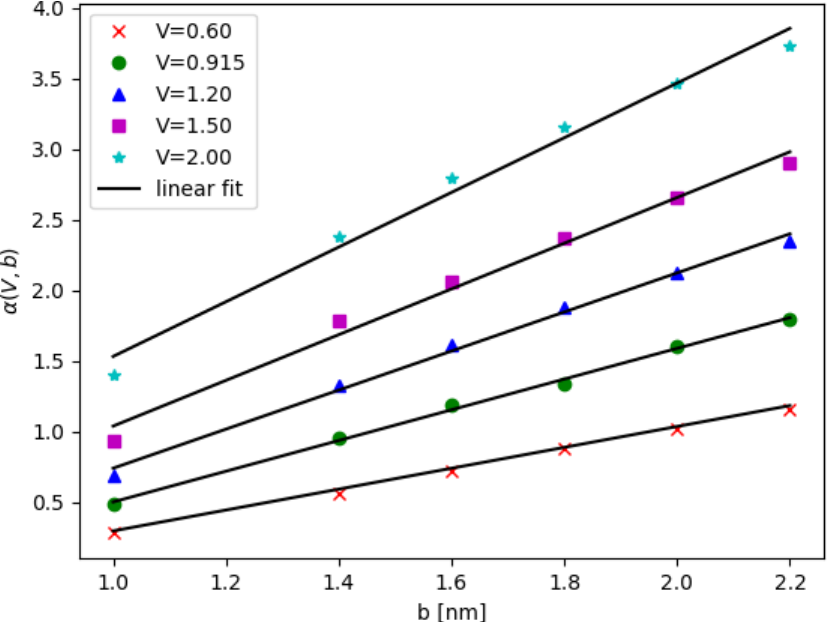
Figure 6. The component α as a function of QD base length b with the different values of potential V , the solid lines are the linear